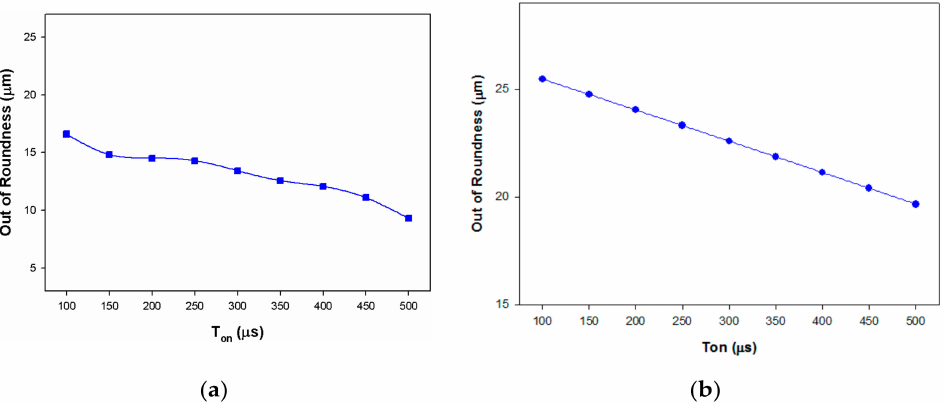
Figure 20. Main effect plots for change in OOR with T on using ( a ) DOE model; ( b ) machine learn- ing